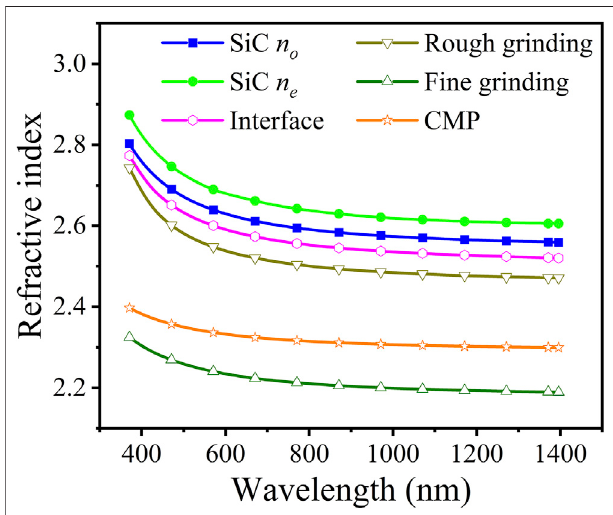
FIGURE 8 | The refractive index of the damage layer of three processed wafers compared with that of 4H-SiC crystal.